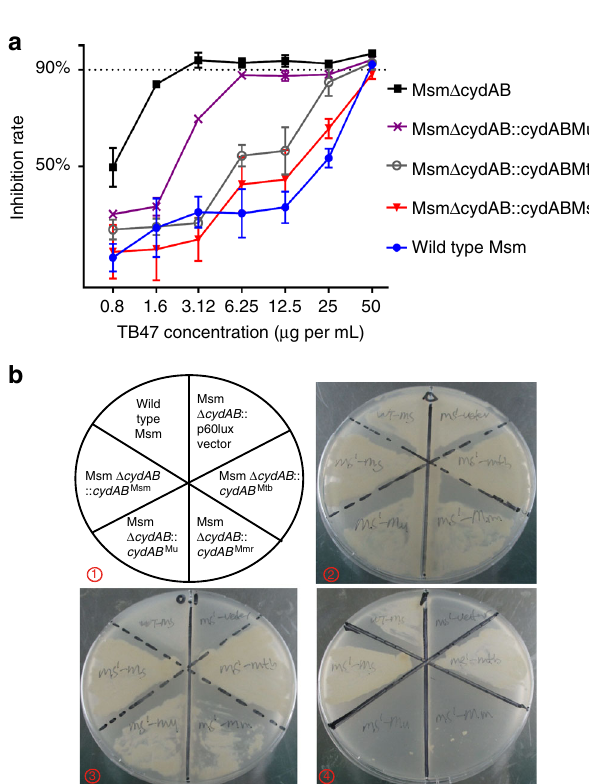
Fig. 5 Effect on the sensitivity to TB47 during the over-expression of CydABs in M. smegmatis . a The inhibition rates against M. smegmatis mc 2 155 and derivative strains. Bacteria treated with different concentrations of TB47 and fl uorescence units (FU) were recorded 4 h post-alamar blue addition. The inhibition rate was calculated as FU treatment /FU untreated × 100% and recorded for each strain per treatment. Data are expressed as mean ± SD from three independent repeats. b Inhibition growth of different M. smegmatis strains by TB47 at different concentrations. ① The plate lay- out is shown ( M. smegmatis containing the construct detailed). ② to ④ showing the plates containing TB47 at 0, 0.1, and 1 ( μ g mL − 1 ) incubated at 37 °C for 36 h. Msm, M. smegmatis ; Mu, M. ulcerans ; Mtb, M. tuberculosis ; Mmr, M.